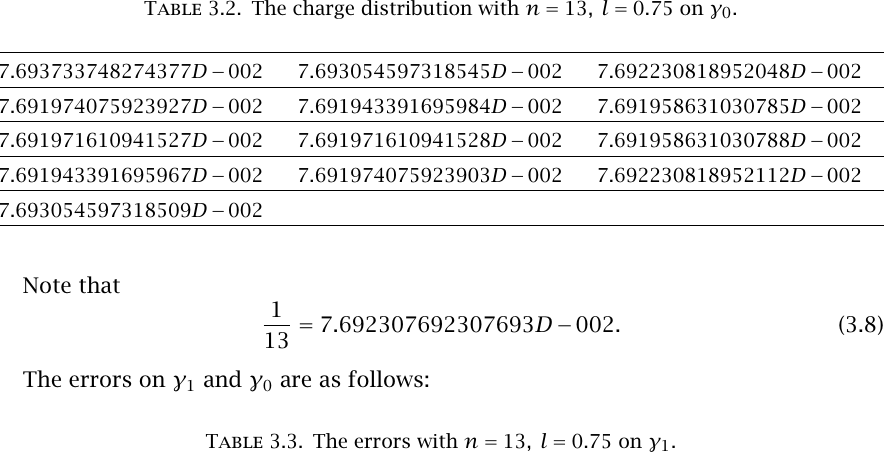
Table 3.2 . The charge distribution with n = 13 , l = 0 . 75 on γ 0 .